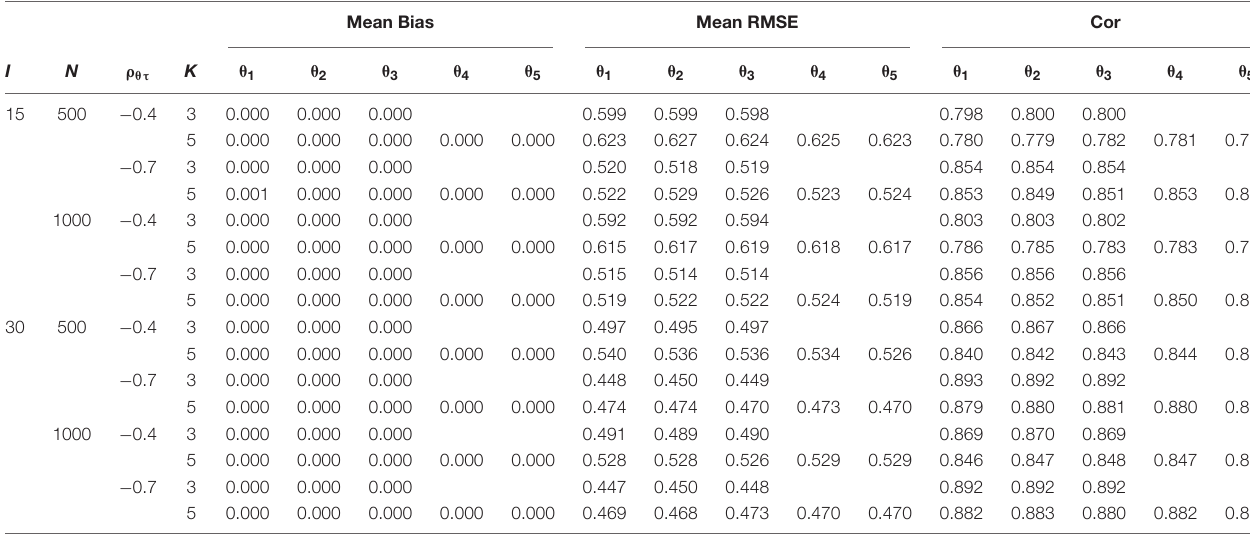
TABLE 5 | Recovery of multidimensional ability in simulation study